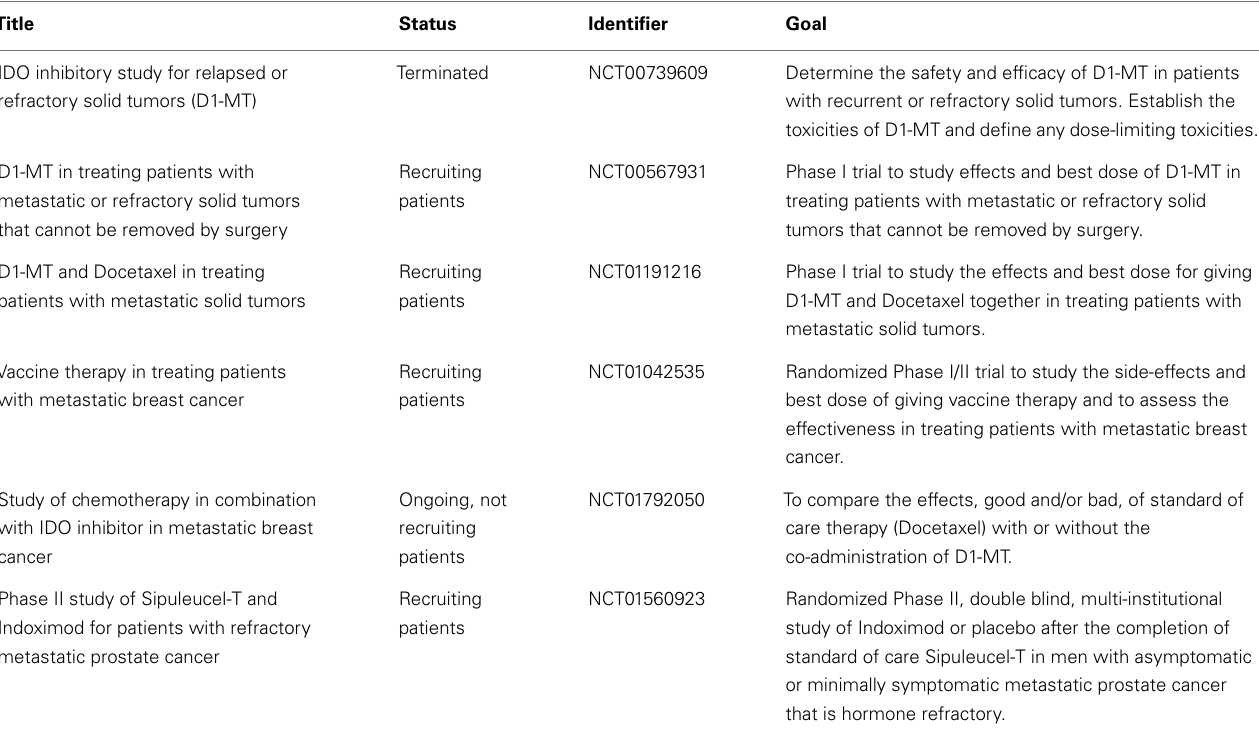
Table 2 | Ongoing clinical trials using 1-MT as an adjuvant